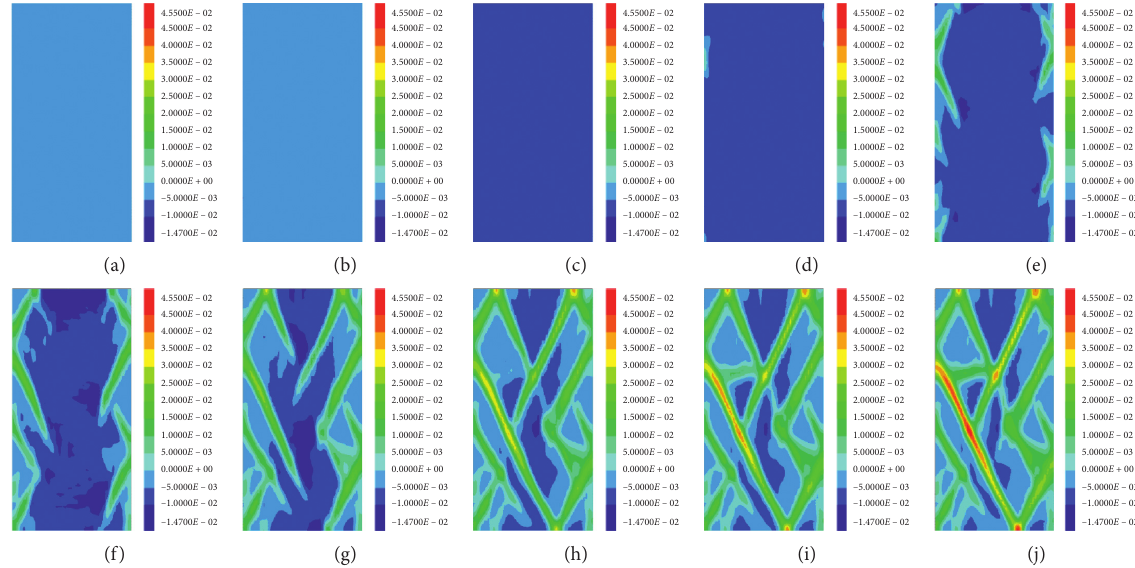
Figure 12: Volumetric strain evolvement at different stress level in simulated triaxial compression test under confining pressure of 20MPa.